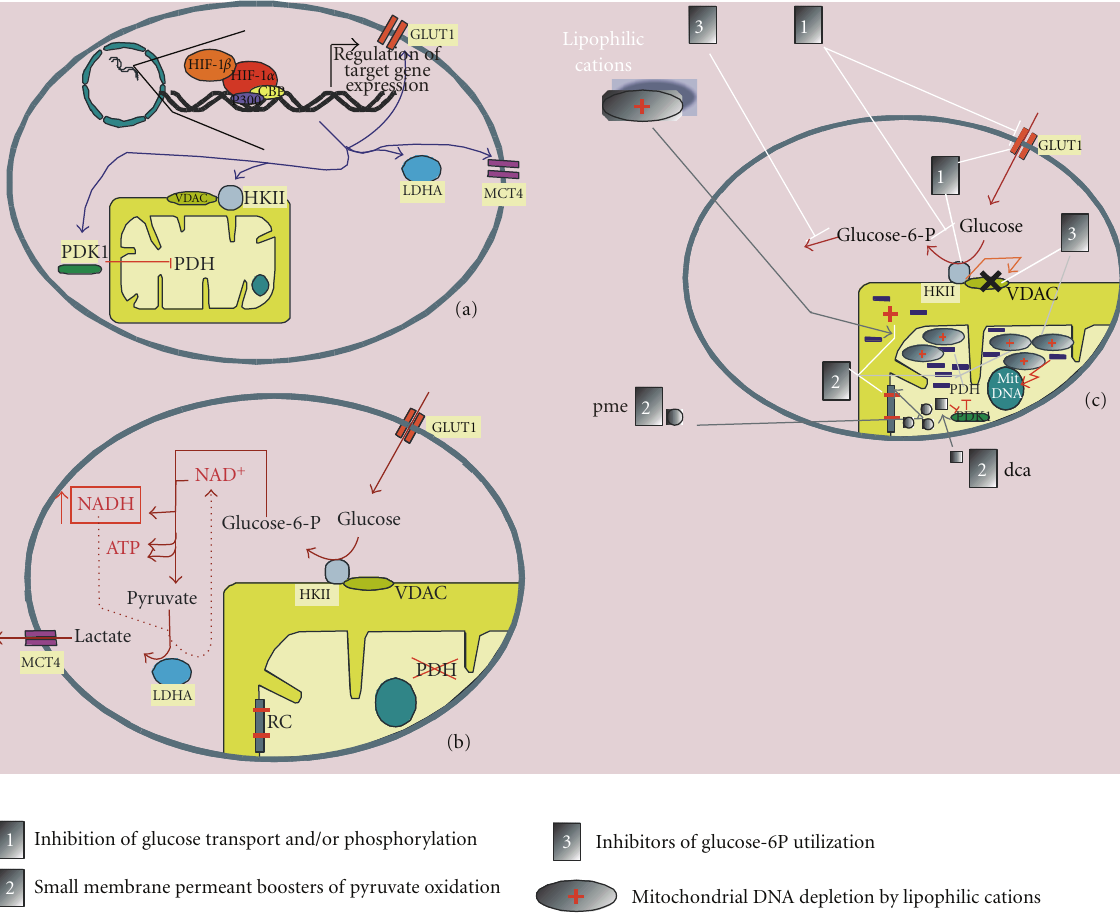
Figure 3: Illustration of how biased HIF-1 signaling in cancer cells may cause Warburg’ e ff ect and lead to modified protein content and sub- cellular localization (a), metabolism (b), and cancer-specific therapeutic opportunities (c). The role of aberrant HIF-1 signalling in cancer cells by encoding proteins (a) which modify the intermediary metabolism in a way that favors the emergence of glycolytic metabolism even in normoxic conditions (b). Note the convergence of the HIF-1-driven increase of proteins, convergence which favors tumor vascularization (Figure 2(a)), and aerobic glycolysis (this figure). Panel (c) illustrates therapeutic opportunities related to cancer cell metabolism. Inhibition of glucose transport and activation disrupts Warburg’s e ff ect, depriving cancer cells of their preferential metabolic substrate. Inhibition of hexokinase may in addition lead to its detachment from mitochondrial VDAC. Blocking the utilization of glucose 6-phosphate by increasing its concentrations secondarily leads to hexokinase inhibition and hence its detachment from VDAC (reopening this channel). Direct interac- tion with VDAC might also disrupt the closed state of the channel. The closed channel may be, however, bypassed by small permeant com- pounds such as pyruvate methyl ester (pme) and dichloroacetate (dca). When VDAC is closed, pyruvate methyl ester, in contrast to pyruvate, can enter the mitochondrial matrix where an esterase produces pyruvate, following this the action of residual pyruvate dehydrogenase generates an electron flux towards the respiratory chain (at the level of complex I), a feature capable of triggering mitochondrial apoptosis. Dichloroacetate inhibits pyruvate dehydrogenase kinase activity and then restores substantial pyruvate dehydrogenase activity and subse- quent flux towards respiratory chain. Lipopphilic cationic compounds are attracted by cancer cell mitochondria which present abnormally high negative electric charges consequently to reduced electron chain proton e ffl ux and to the closed state of VDAC (resulting in accumu- lation of small negative metabolites trapped within the mitochondria). Lipohilic cations may cross mitochondrial membranes, bypassing VDAC and being insensitive to the closed state of this channel. The intramitochondrial accumulation of lipophilic cations induces destruc- tion and depletion of mitochondrial DNA. Abbreviations are GLUT1, glucose transporter 1; LDHA, lactate dehydrogenase A; MCT4, mono- carboxylate transporter 4; PDH, pyruvate dehydrogenase; PDK, pyruvate dehydrogenase kinase1; HKII, hexokinase II; VDAC, voltage-de- pendent anionic channel; pme, pyruvic methyl ester; dca, dichloracetate; RC, respiratory